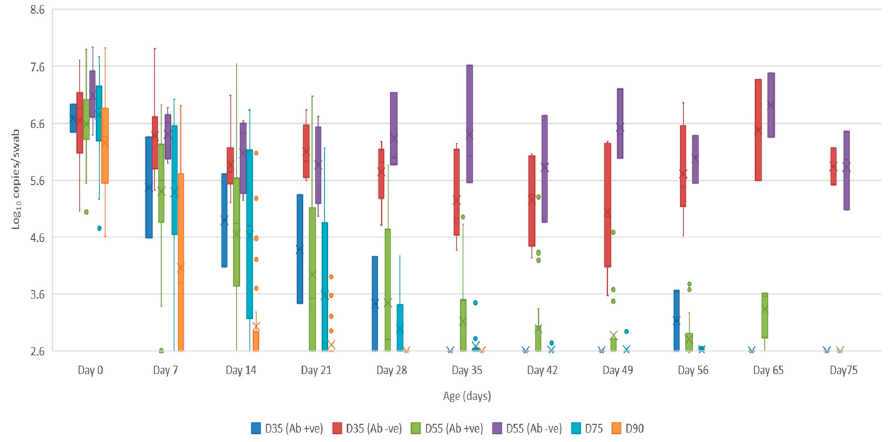
Figure 4. Box and whisker plot summarising the quantity of Bungowannah virus detected on oropharyngeal swabs between 0 to 75 days of age following in utero infection at one of four stages of gestation (x = mean; — = median; the whiskers extend up from the top of the box to the largest data element that is less than or equal to 1.5 times the interquartile range (IQR) and down from the bottom of the box to the smallest data element that is larger than 1.5 times the IQR. Values outside this range are considered outliers and are represented by dots).